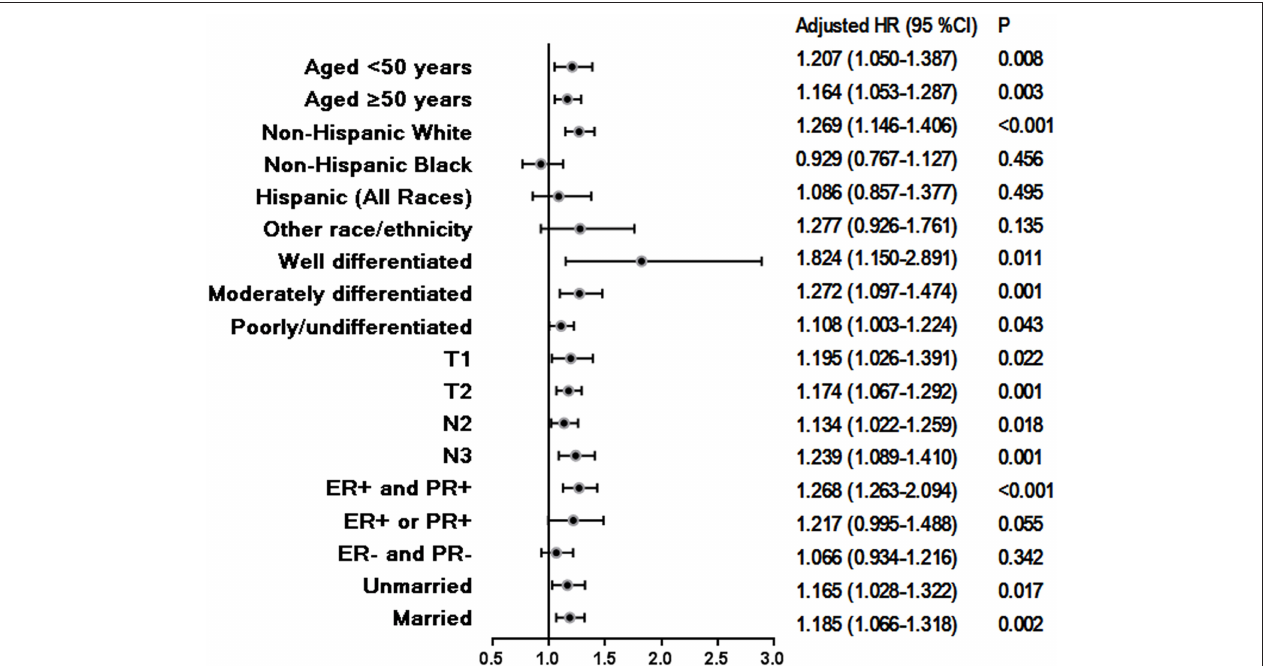
FIGURE 4 | Hazard ratios for breast-conserving surgery compared to mastectomy with regard to breast cancer-specific survival in relation to predefined prognostic